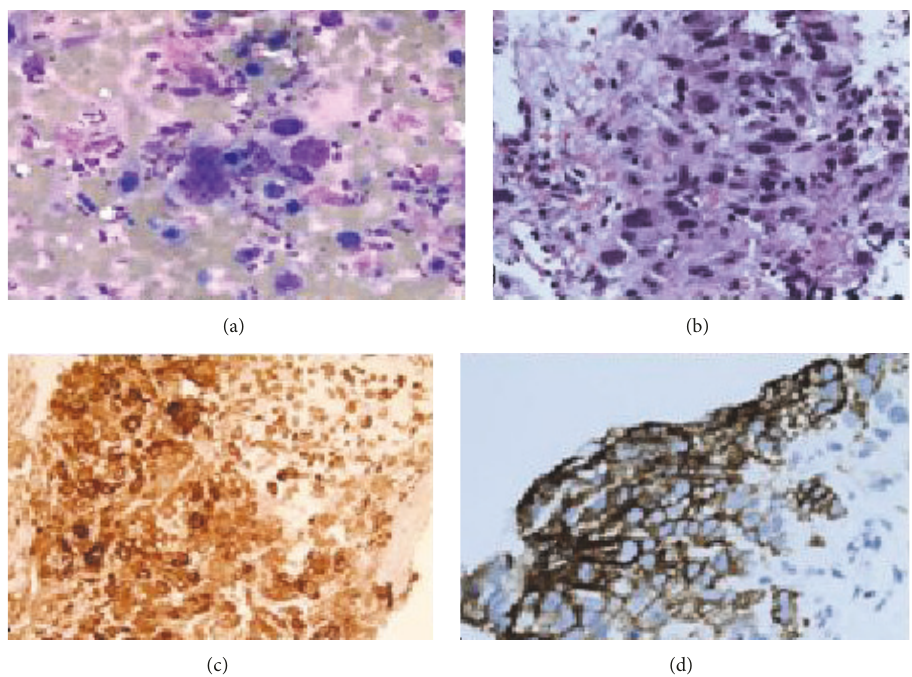
Figure 4: RUL mass biopsy. (a) Touch imprint cytology from core needle biopsy demonstrates bizarre, pleomorphic cells arranged in a dissociative fashion. Some of the tumor cells are multilobulated to multinucleated with pleomorphic, hyperchromatic nuclei (Diff-Quik stain × 20). (b) Core needle biopsy reveals bizarre syncytiotrophoblasts characterized by pleomorphic cells, including some that are multilobulated to multinucleated. The cells have a moderate amount of surrounding eosinophilic cytoplasm. Extensive necrosis is noted in the cores (H&E × 20). (c) Immunohistochemical stain for beta-hCG shows intense strong positive cytoplasmic staining ( × 40). (d) Strong diffuse positive cytoplasmic and membranous staining for PLAP ( ×